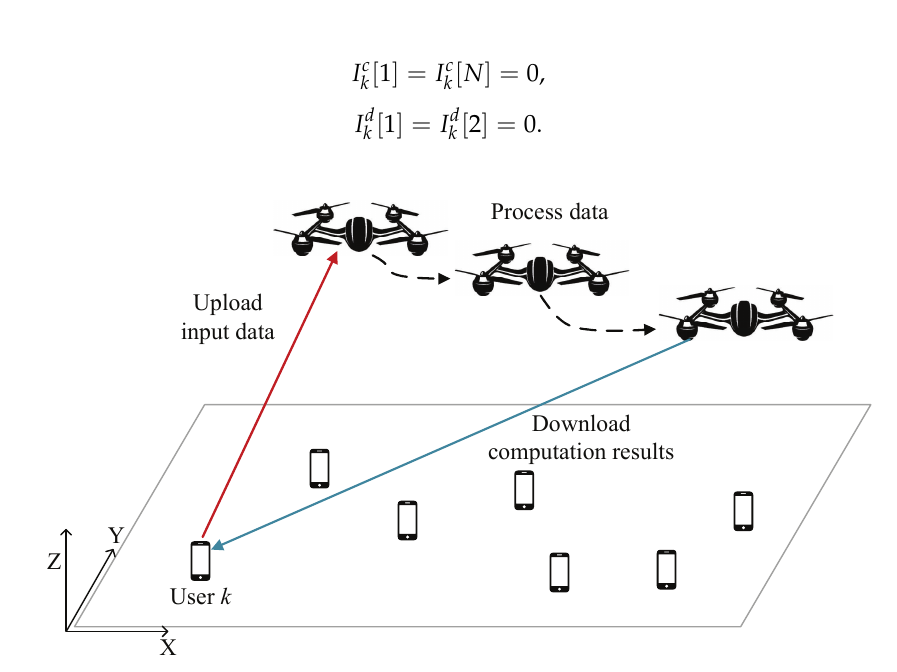
Figure 3. The slots and sub-slots in